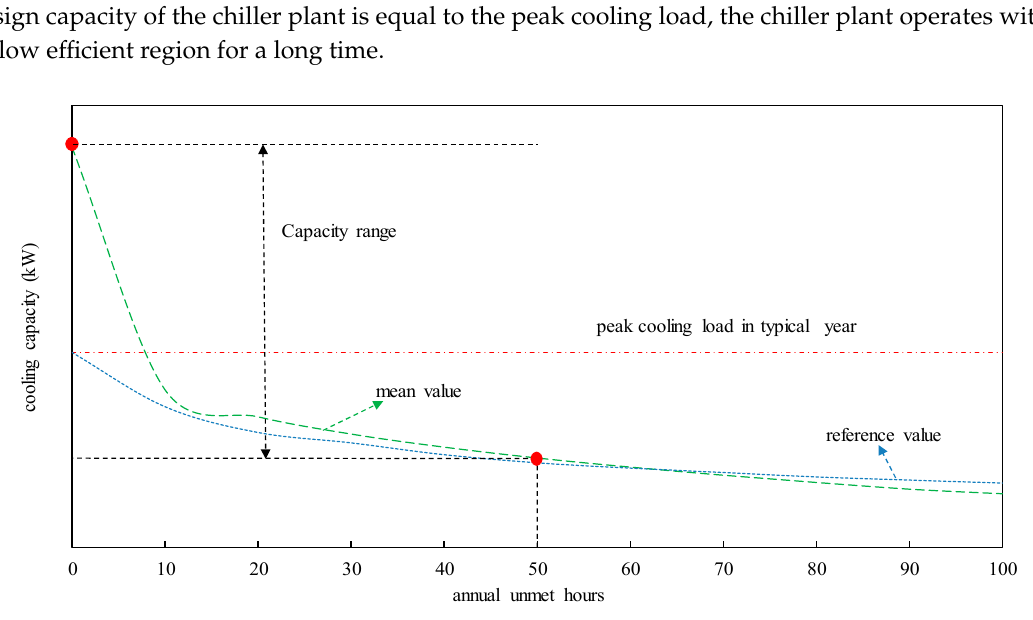
Figure 4. Cooling capacity vs. unmet hours.